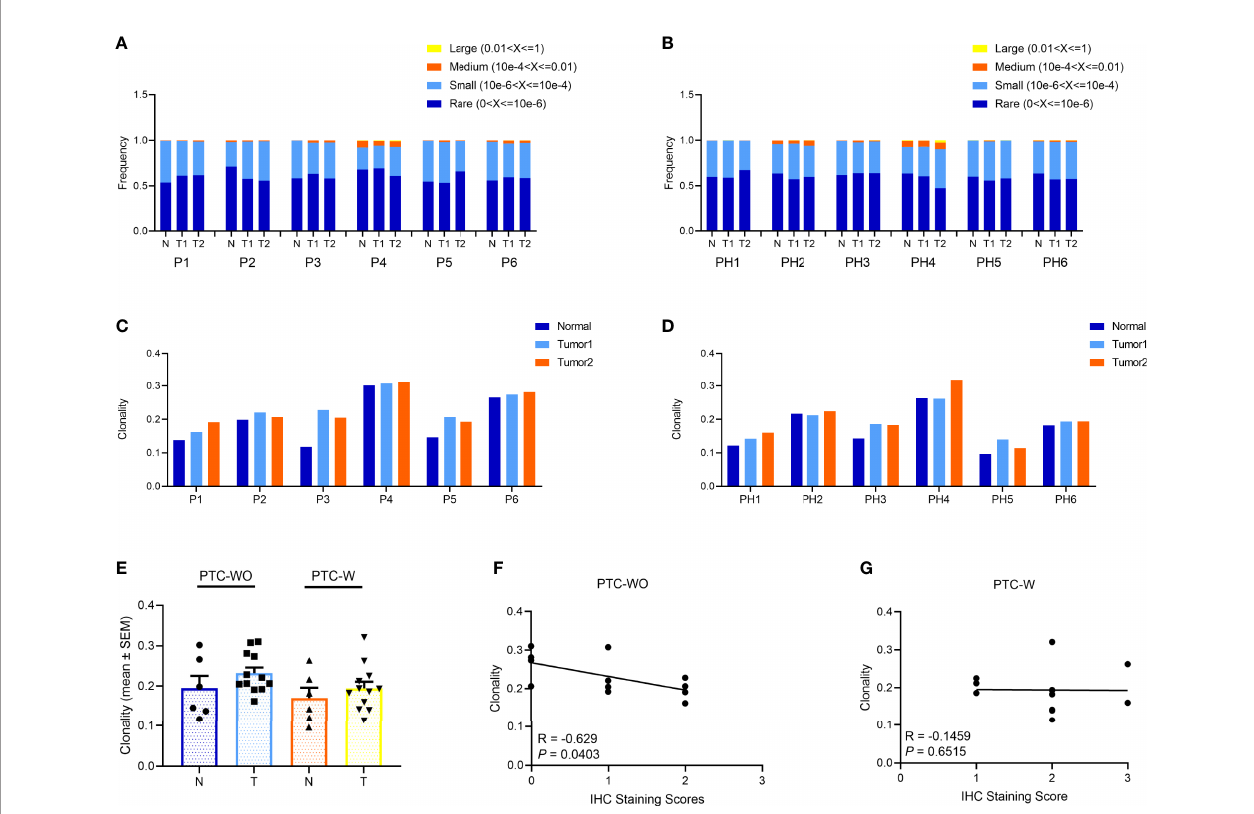
FIGURE 2 | The clonal distribution of the TCR repertoire in PTC with and without HT. (A, B) The frequency distribution of TCR clones in PTC with and without HT. (C, D) The TCR clonality in PTC with and without HT. (E) Comparison of TCR clonality of tumor and normal samples in PTC with and without HT. (F, G) Spearman correlation between clonality and IHC staining score of CD3+ T cells in PTC with and without